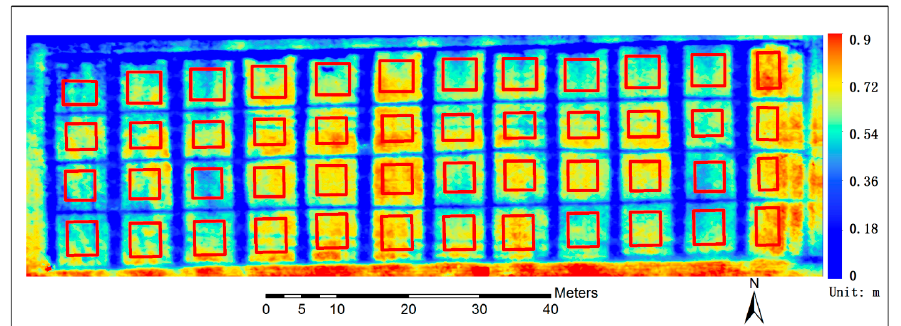
Figure 10. Generated surface crop model (CSM) and shape file for sampling plots (red rectangles).